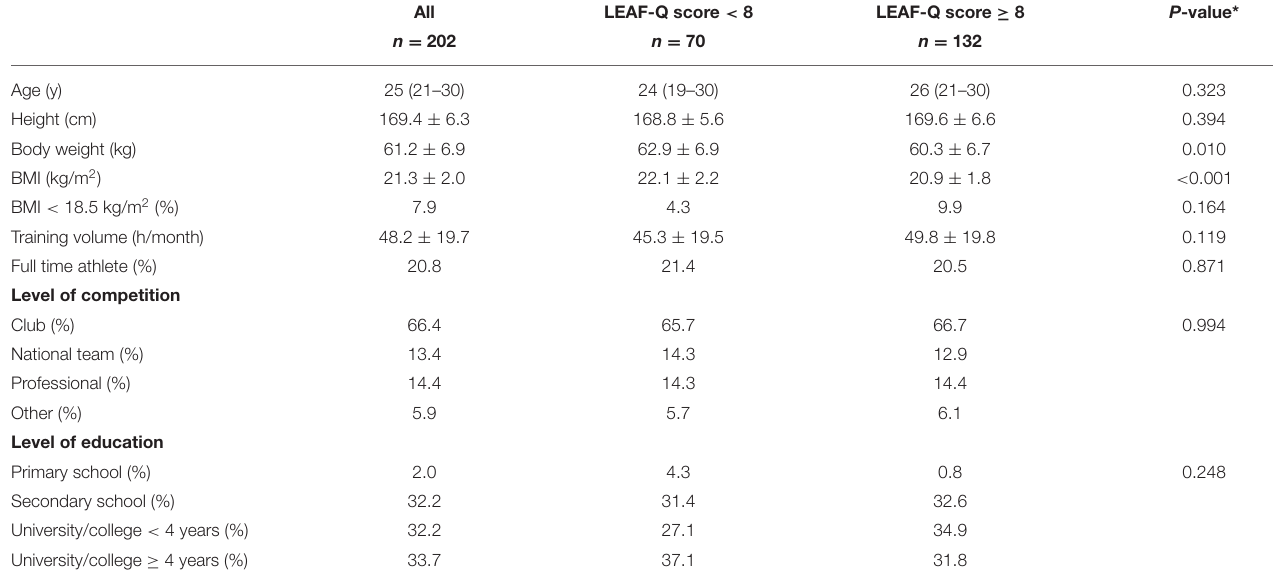
TABLE 1 | Description of subjects characterized by energy availability status.